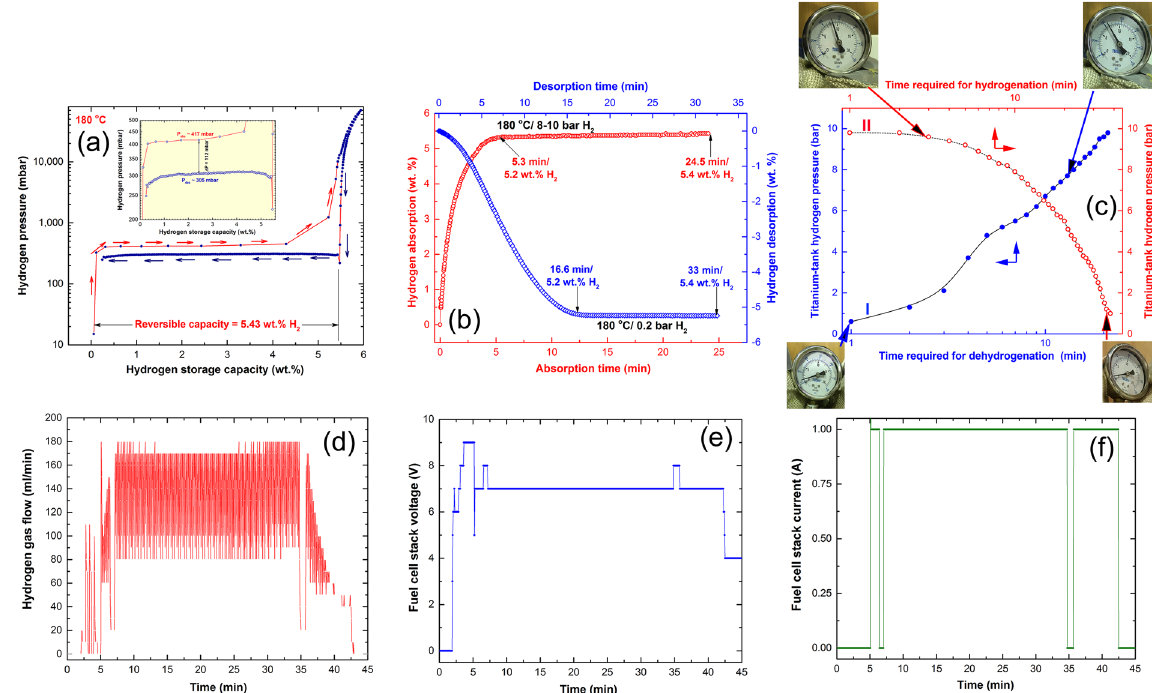
Figure 10. Characterization of fuel cell system fed by hydrogen gas flow released from nanocomposite MgH 2 /5 wt.% TiMn 2 powders. PCT and hydrogenation/dehydrogenation kinetics curves conducted at 180 °C are shown in ( a , b ), respectively. The time required for hydrogenation/dehydrogenation conducted at 180 °C for Ti-tank is plotted vs the corresponding pressure in ( c ). The hydrogen gas flow provided during charging cell-phone’s battery is presented in ( d ). Correlation between charging time and fuel cell- stack ( e ) current, and ( c )